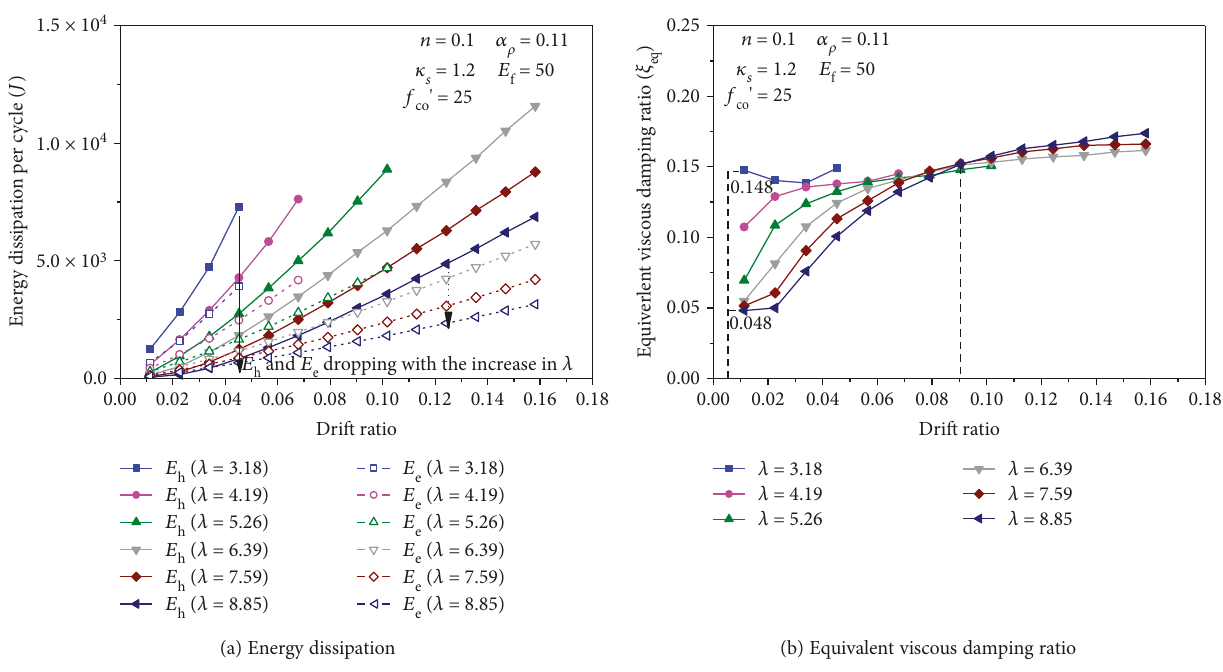
Figure 12: Variation of energy dissipation indicators with drift ratio along with λ .